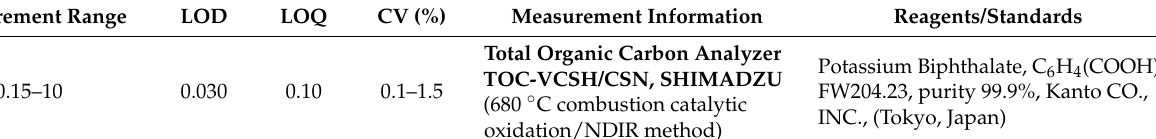
Table 1. Validation parameters, technical specifications and reagents used in the applied analytical